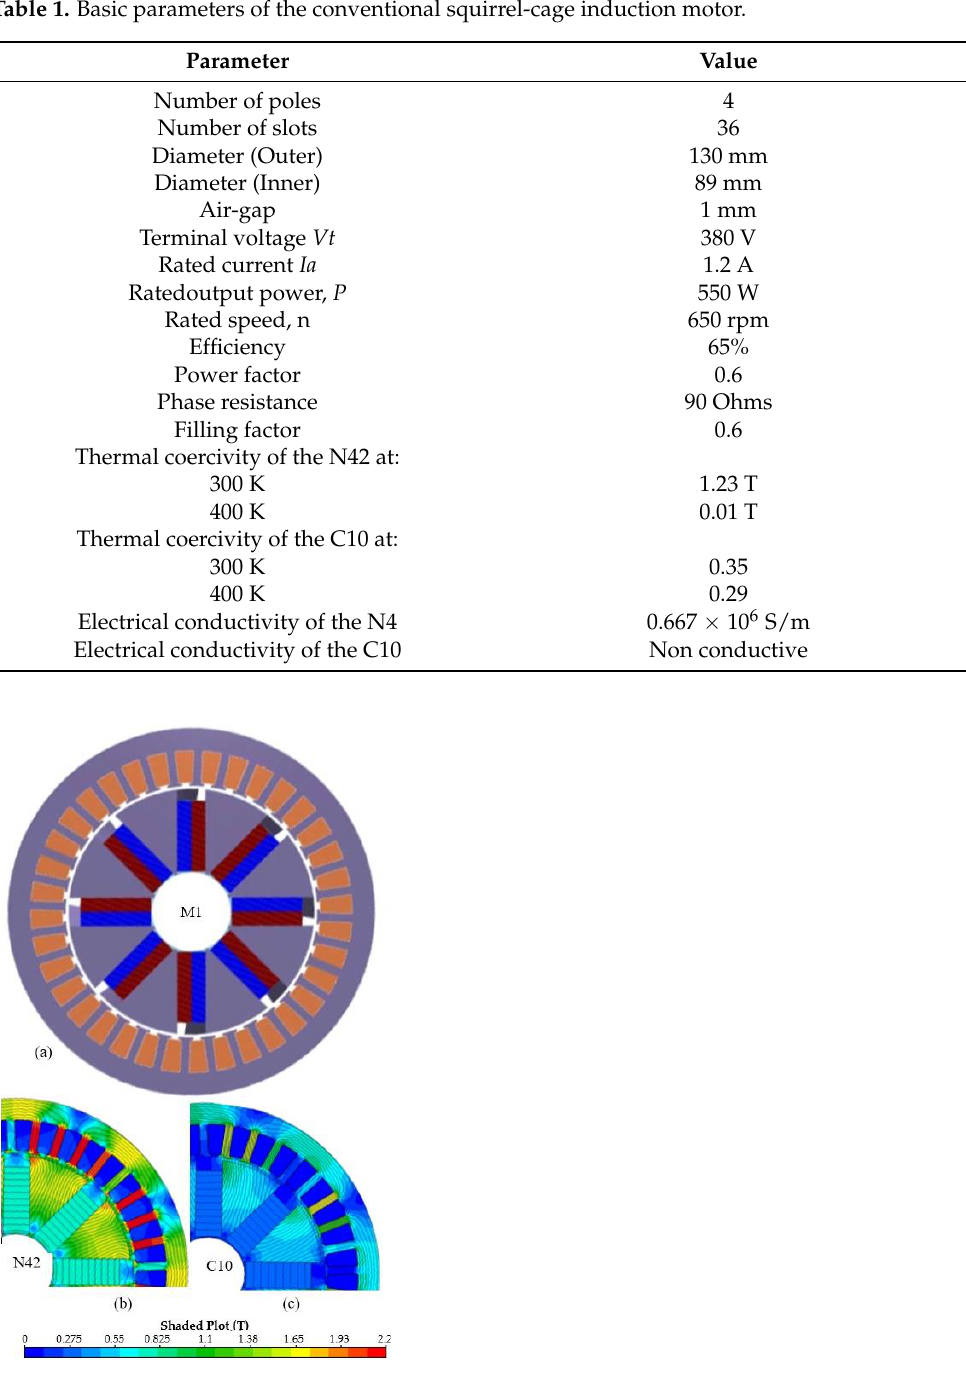
Figure 2. Radial machine: ( a ) general view, ( b ) magnetic flux density in the stator and rotor core of N42 PM machine, ( c ) magnetic flux density distribution in the stator and rotor core of C10 PM ma- chines.